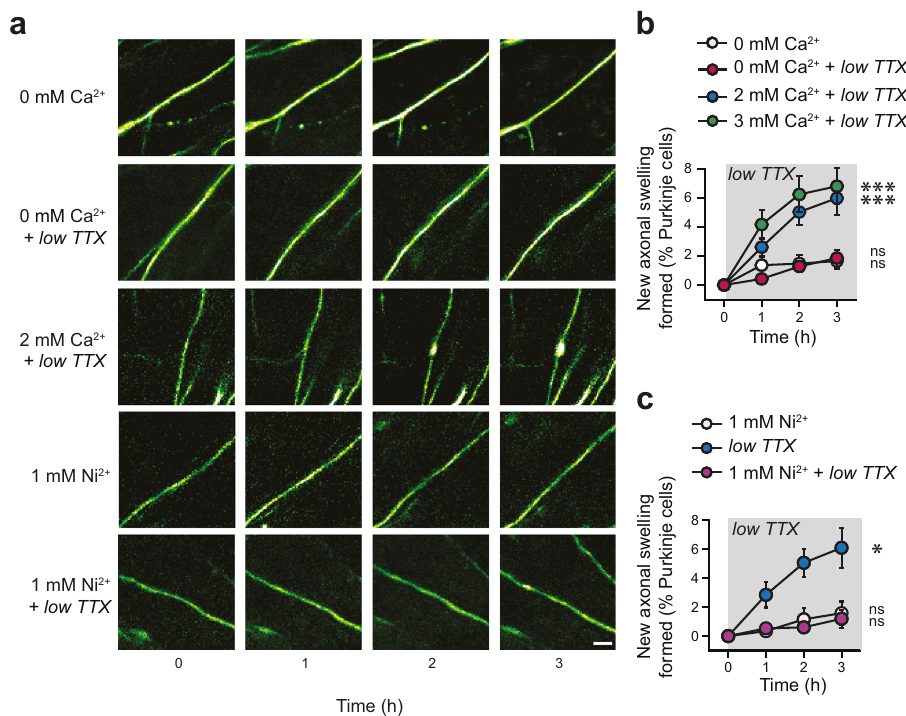
Fig. 5 Axonal swelling formation requires calcium in fl ux through voltage-gated Ca 2 + channels. a Representative time-lapse images during bath application of ACSF containing no Ca 2 + (0 mM Ca 2 + , top), 0 mM Ca 2 + with low TTX (second row), low TTX with 2 mM Ca 2 + (third row). The formation of axonal swellings in low TTX is occluded by the presence of 1 mM Ni 2 + (fourth row), and Ni 2 + without TTX does not produce axonal swelling formation. Scale bar, 5 μ m. b Axonal swellings do not form in l ow TTX with 0 mM Ca 2 + , but do form in both 2 mM and 3 mM Ca 2 + (repeated measures ANOVA; 0 mM Ca 2 + , n = 12, P = 0.25; 0 Ca 2 + + low TTX, n = 15, P = 0.16; 2 mM Ca 2 + (2 mM) + low TTX, n = 14, P < 0.001; 3 mM Ca 2 + + low TTX, n = 12, P < 0.001). c Summary data showing low TTX ACSF containing 1 mM Ni 2 + occludes the formation of axonal swellings. (repeated measures ANOVA; ACSF containing 1 mM Ni 2 + , n = 6, P = 0.78; low TTX, n = 14, P < 0.001; 1 mM Ni 2 + + low TTX, n = 8, P = 0.80). Data were presented as mean ± SEM (*** P < 0.001; * P < 0.05. ns P > 0.05). Source data are provided as a Source Data fi